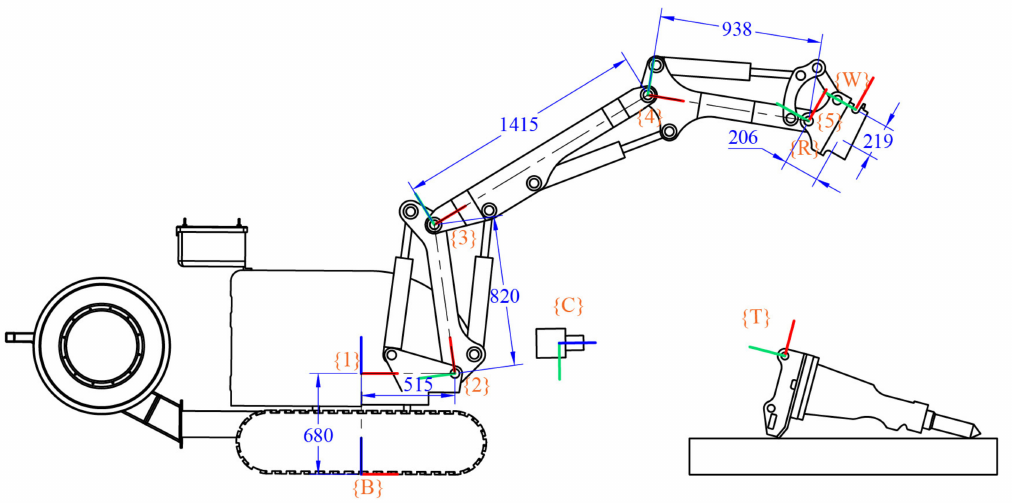
Figure 3. Demolition robot model. { B } is the robot’s base coordinate frame, { W } is the quick-hitch docking spot coordinate frame, { C } is the camera coordinate frame, { T } is the attachment docking spot coordinate frame, and { R } is the error compensation reference coordinate frame (the red axis is the X-axis, the green axis is the Y-axis, and the blue axis is the